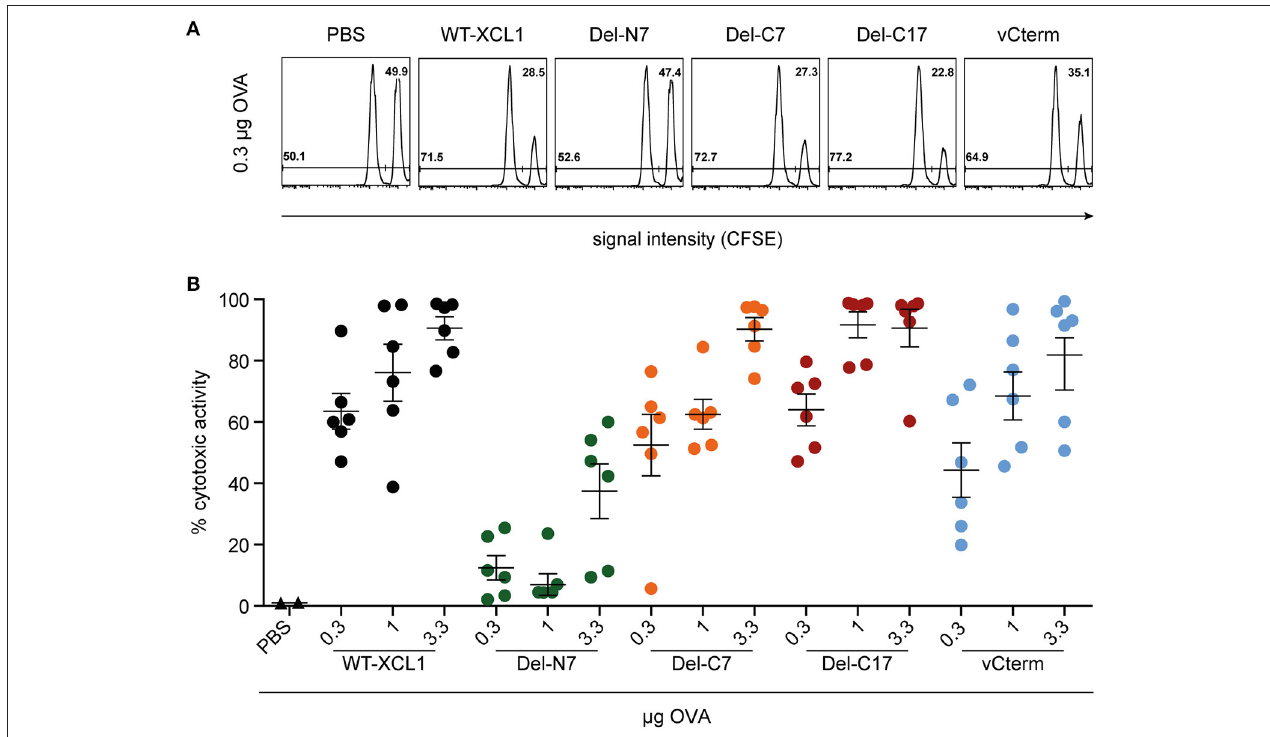
FIGURE 6 | Induction of cytotoxic capacity after in vivo targeting of antigen with XCL1-OVA and its variants Del-N7, Del-C7, Del-C17, and vCterm . C57BL/6 mice were immunized with the indicated amounts of wt XCL1-OVA and its variants (based on the content of OVA) together with 3 µ g LPS on day 0. On day 6, the animals were injected with CFSE-labeled target cells to quantitate the induced cytotoxicity in vivo (for details, see Materials and Methods). (A) Exemplary flow cytometry histograms of the data obtained with 0.3 µ g of each reagent. (B) Percentage of specific lysis obtained with 0.3, 1 and 3.3 µ g of each reagent (mean ±